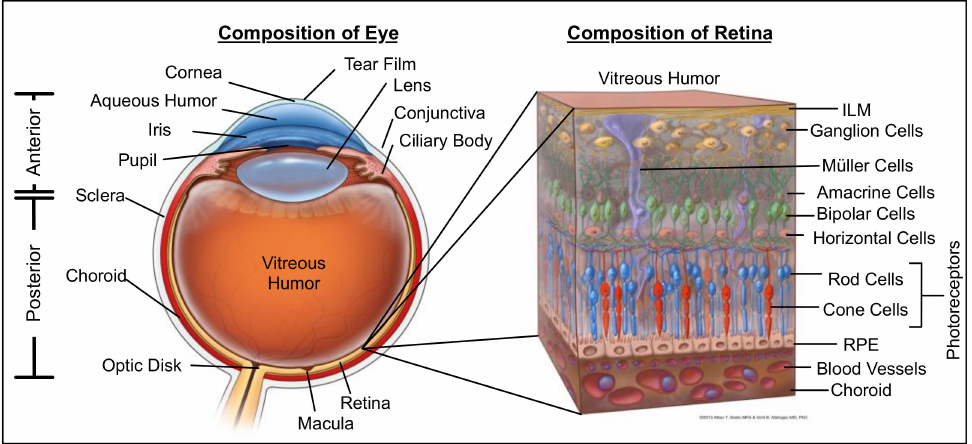
Figure 1. Structure and components of the eye and retina. The eye is composed of various tissues and the retina is located on the inner layer of eyes with distinct cell layers. ILM: internal limiting membrane; RPE: retinal pigment epithelium.